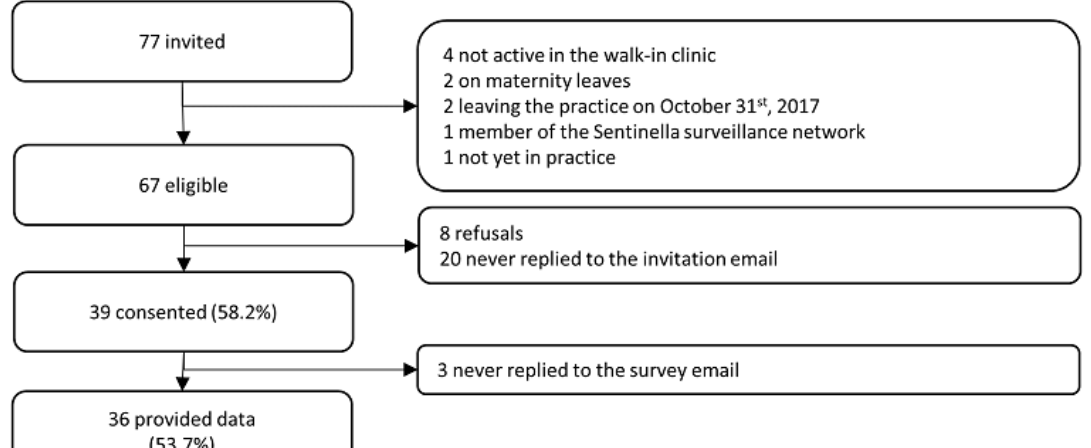
Figure 3. Participant flow chart, feasibility study of an online influenza surveillance system among primary care workers of three clinics in Switzerland, 2017-2018.